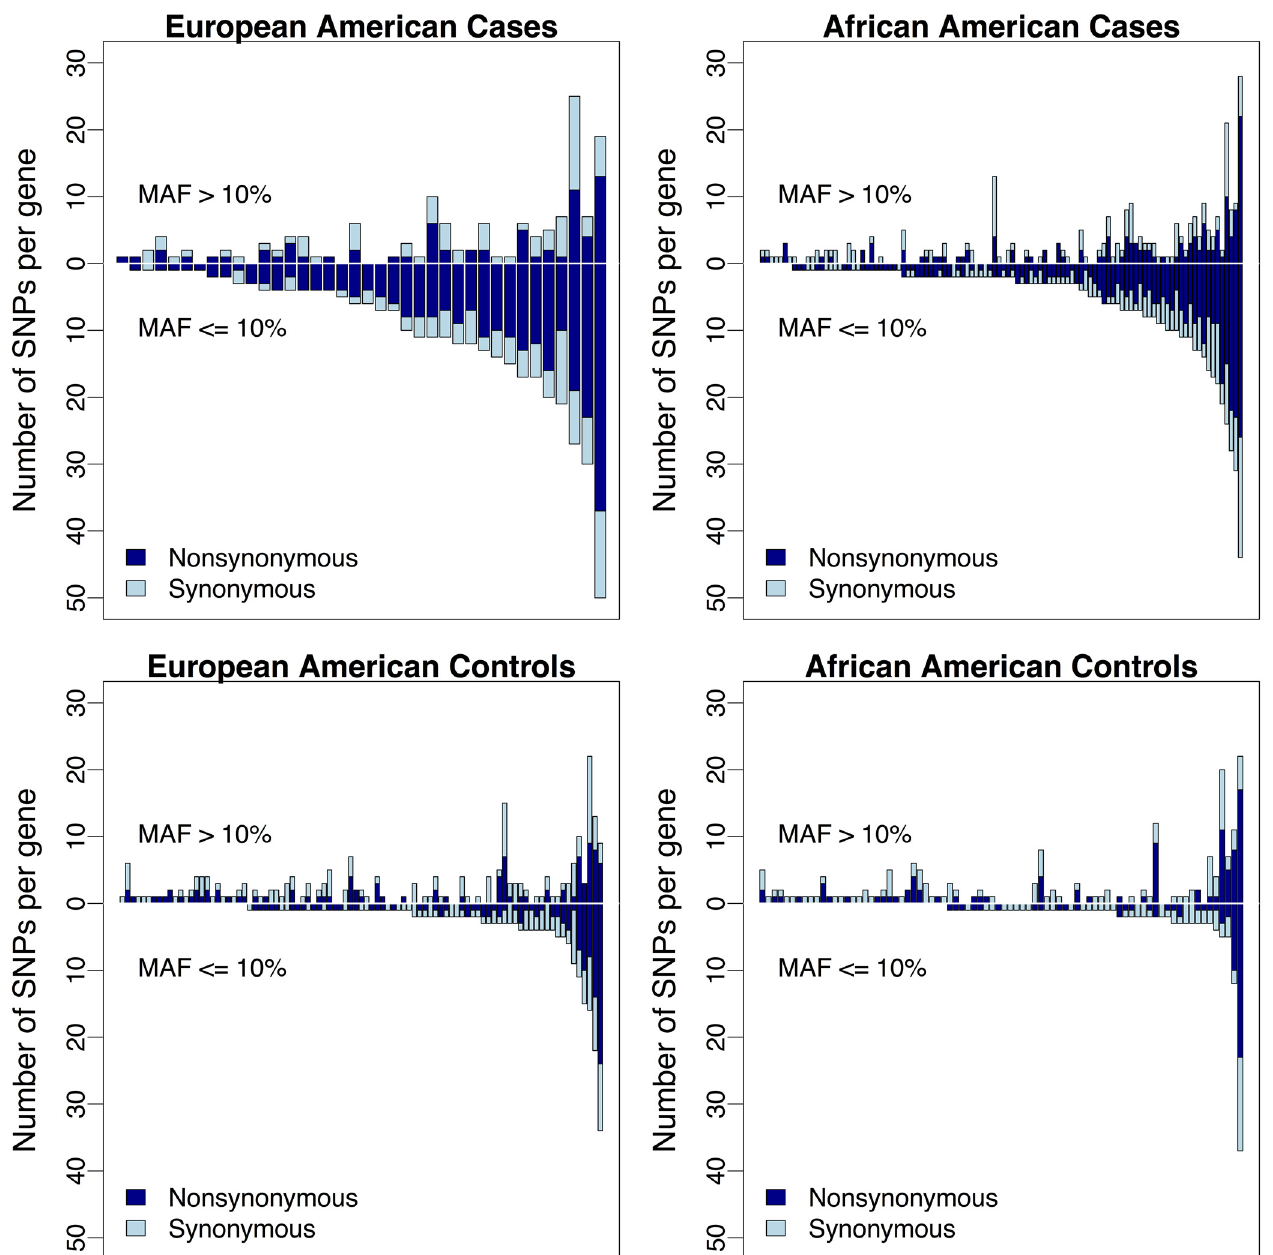
Fig 2. QQplot showing the results of association testing at nonsynonymous variants for physician-diagnosed asthma following severe RSV bronchiolitis in infancy. Genotypes from the exome sequencing project (ESP) were used as controls. The shaded area represents the 95% confidence